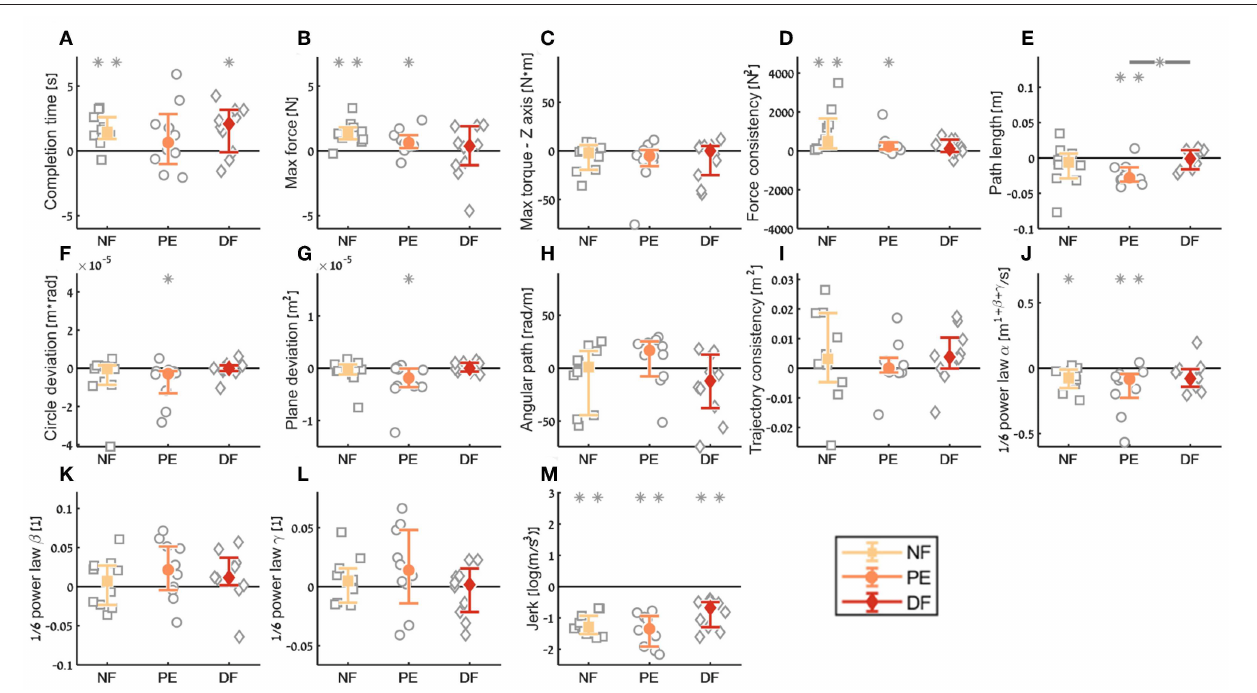
FIGURE 11 | Summary of the dVRK teleoperation final performance compared to baseline for the insertion subtask. For each metric (A–M) , median of difference between late teleoperation stage to late first open stage is presented. Each gray marker represent individual subject. Error bars shows median of each group difference (NF, PE, and DF) and 95% bootstrap confidence interval. Gray asterisks represent the result of a Wilcoxon sign rank test for difference from